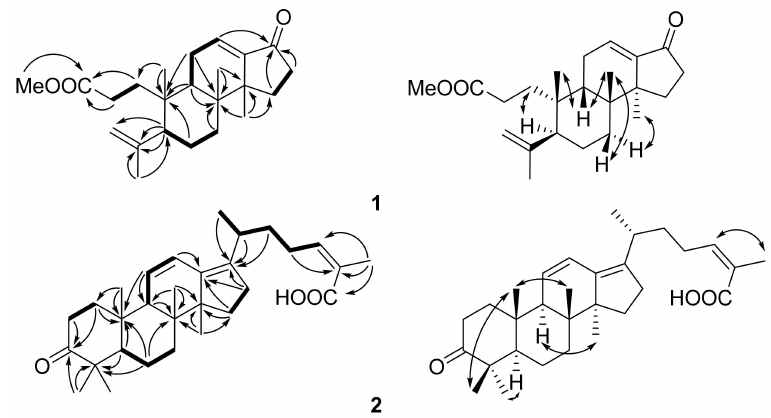
Figure 2. Key 1 H- 1 H COSY ( ), HMBC (H → C), and ROESY ( ↔ ) correlations of 1 – 2 . Table 1. 1 H (500 MHz) and 13 C nuclear magnetic resonance (NMR) (125 MHz) Data of Compounds 1 – 2